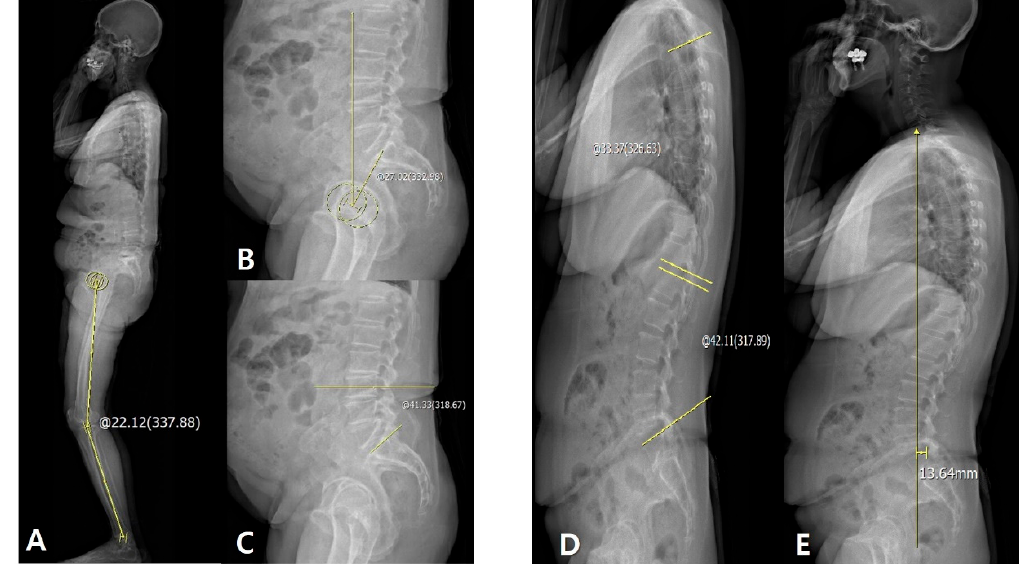
Figure 1. ( A ) Measurement of hip–knee–ankle (HKA) angle: +22.12°. ( B ) Measurement of PT: +27.02°. ( C ) Measurement of SS: +41.33°. ( D ) Measurement of TK and LL: +33.37° and +42.11°, respectively. ( E ) Measurement of C7 plumb line-sacrum distance: +13.64 mm. The sagittal HKA angle was defined as the angle between two lines: One joining the center of the femoral head and the center of the knee and the other joining the center of the knee and the center of the superiaor articular surface of the